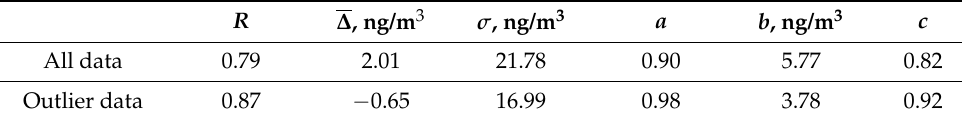
Figure 1. Regression relationship of black carbon concentrations measured by two methods. Table 1. Statistical characteristics of the regression relationship M BC 1 – M BC 2 .